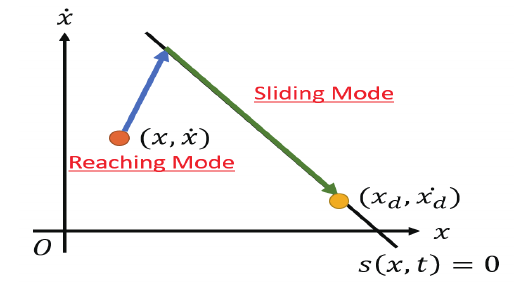
Figure 1. Graphical interpretation of SMC